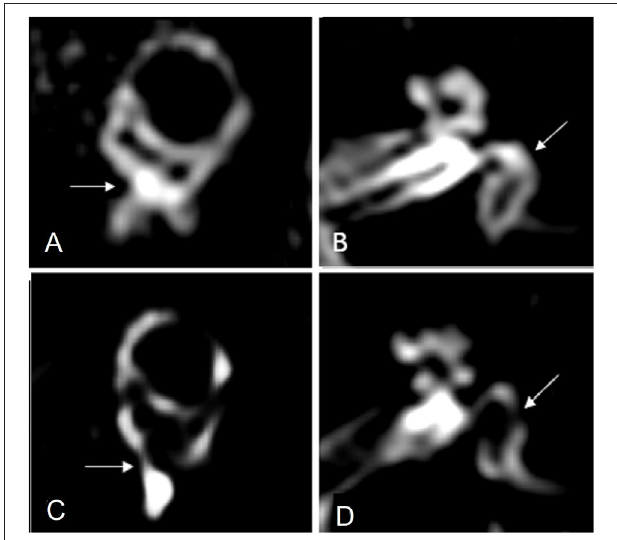
FIGURE 1 | (A) MR imaging oblique sagittal reconstruction parallel to the superior semicircular canal of a healthy ear shows superiorly the vestibular endolymphatic space and inferiorly the perilymph filling the inferior third of the vestibule with preservation of the perilymph signal medial to the oval window (arrow). (B) MR imaging axial reconstruction parallel to the lateral semicircular canal at the inferior third of the vestibule in a healthy subject, showing the vestibule filled by the perilymph (arrow). (C) MR imaging oblique sagittal reconstruction parallel to the superior semicircular canal in a patient with Menière disease shows enlargement of the vestibular endolymphatic space bulging into the inferior third of the vestibule and contacting the oval window (arrow), with the consequent absence of the normal perilymph signal. (D) MR imaging axial reconstruction parallel to the lateral semicircular canal at the inferior third of the vestibule shows the vestibular endolymphatic space contacting the oval window, “VESCO”